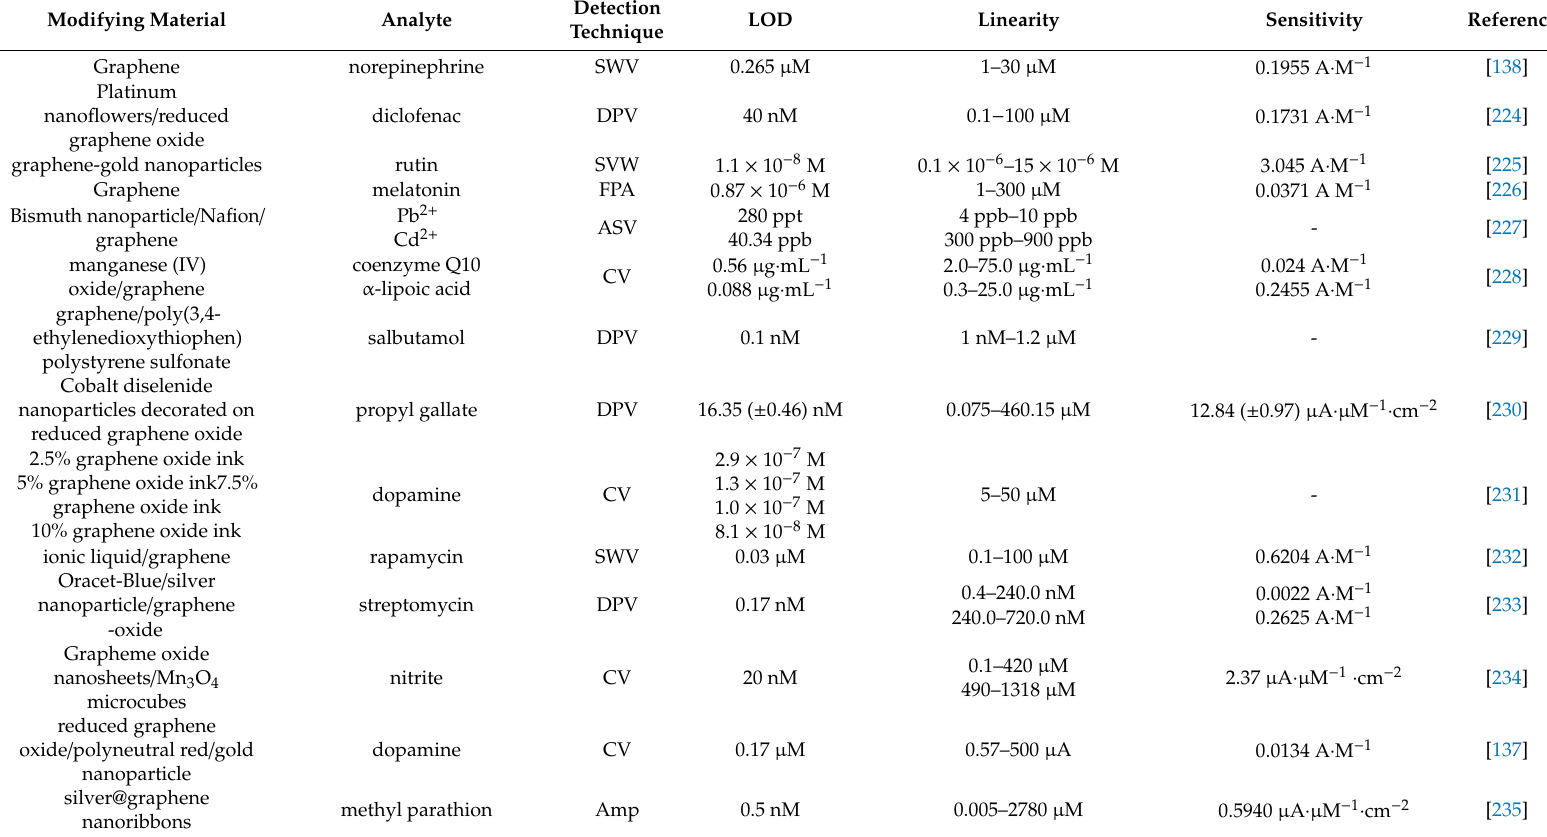
Table 1. Principal novel sensors based on screen-printed electrodes modified with carbonaceous